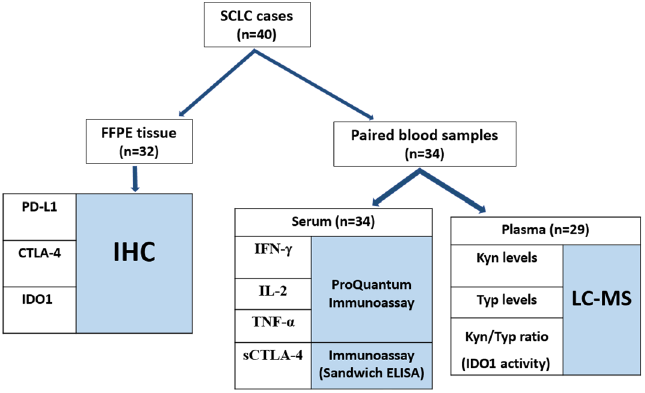
Figure 1. Workflow of the study along with available samples for